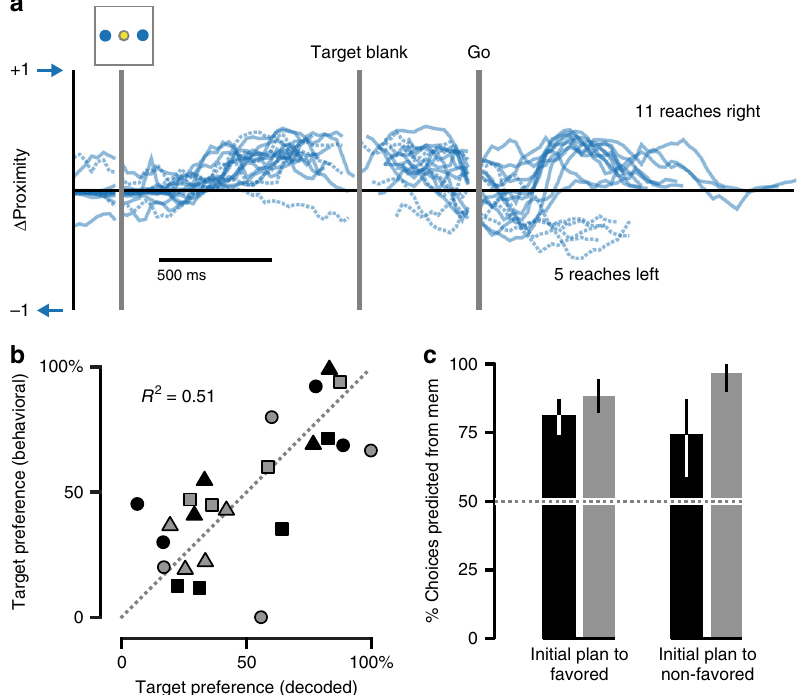
Fig. 8 Neural preferences match Free-Choice behavior. a Δ Proximity traces for all left/right Free-Choice trials in the example session from Fig. 4a. The monkey chose the rightward target on 11 of the 16 trials. b Across all sessions, the monkeys ’ decisions on Free-Choice trials for each axis correlated with their planning preferences decoded from cued 2-Target trials. Black symbols correspond to monkey C, gray symbols to monkey M. Symbol shape corresponds to the different sessions, as in Fig. 7c. c Bar plot indicating the degree to which Target Blank period activity successfully predicted the monkeys ’ choices on Free-Choice trials for each session and target axis. Black bars correspond to monkey C, gray to monkey M. Error bars represent 95% con fi dence bounds calculated from the standard